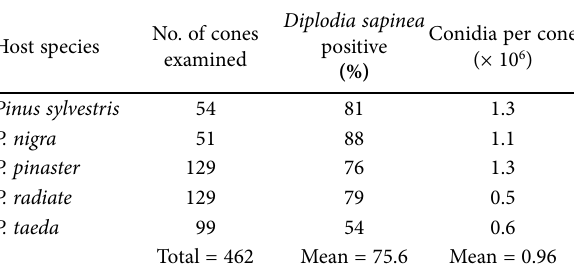
Table 4. Occurrence of Diplodia sapinea in cones of pine species and recovery of conidia in suspensions.